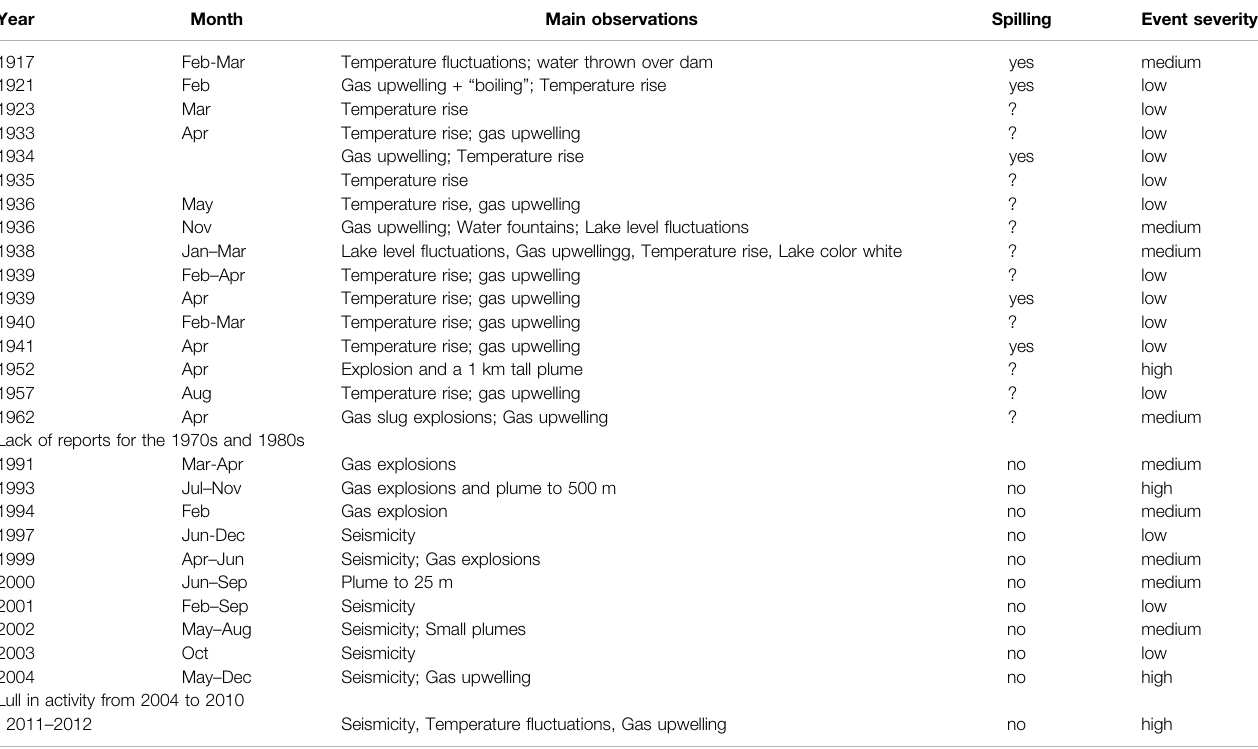
TABLE 5 | Summary of volcanic unrest reported for Kawah Ijen volcano, dominated by phreatic explosions and gas